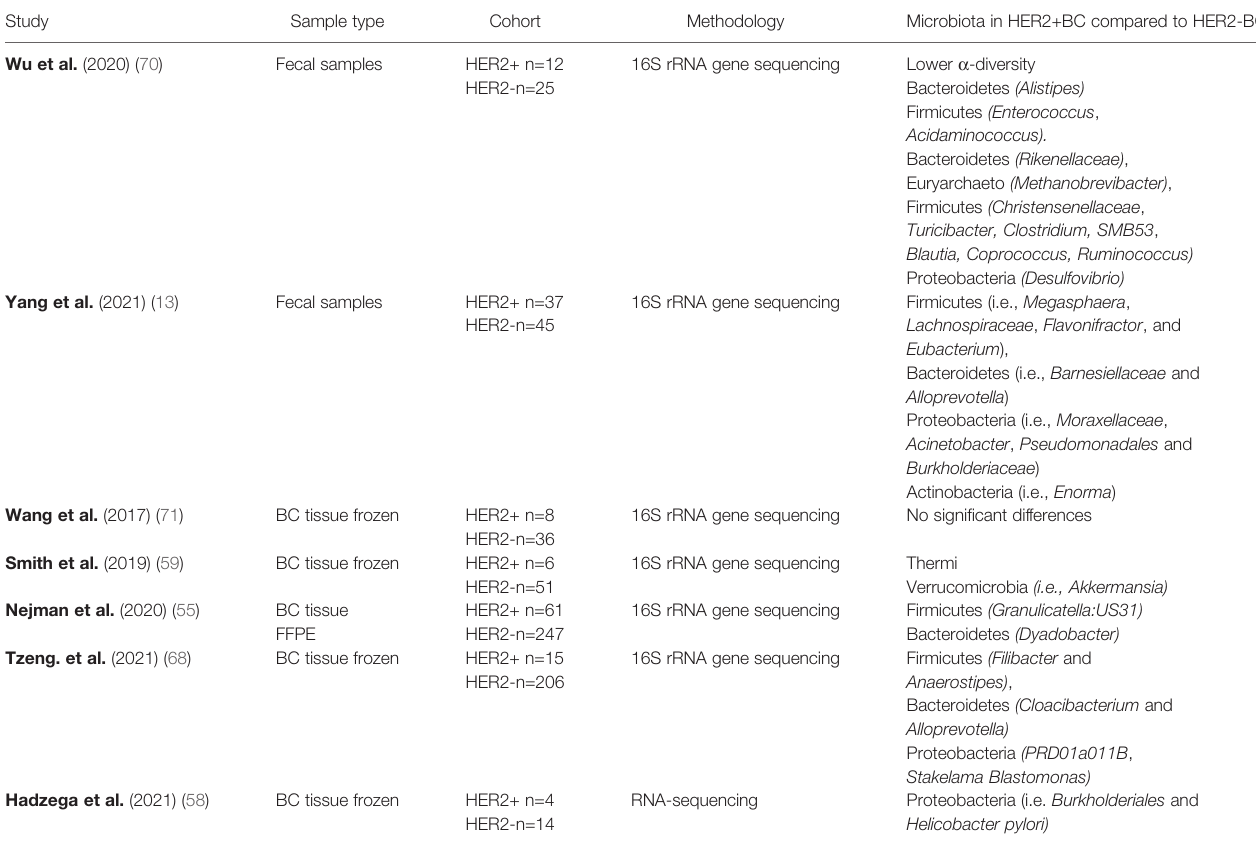
TABLE 1 | Bacterial signature in HER2+ BC subtype. BC, breast cancer; FFPE, formalin- fi xed paraf fi